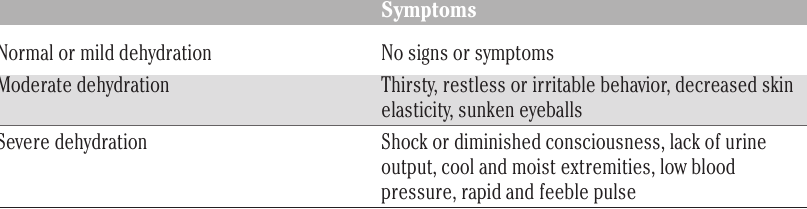
Table 1. Scale of hydration status.